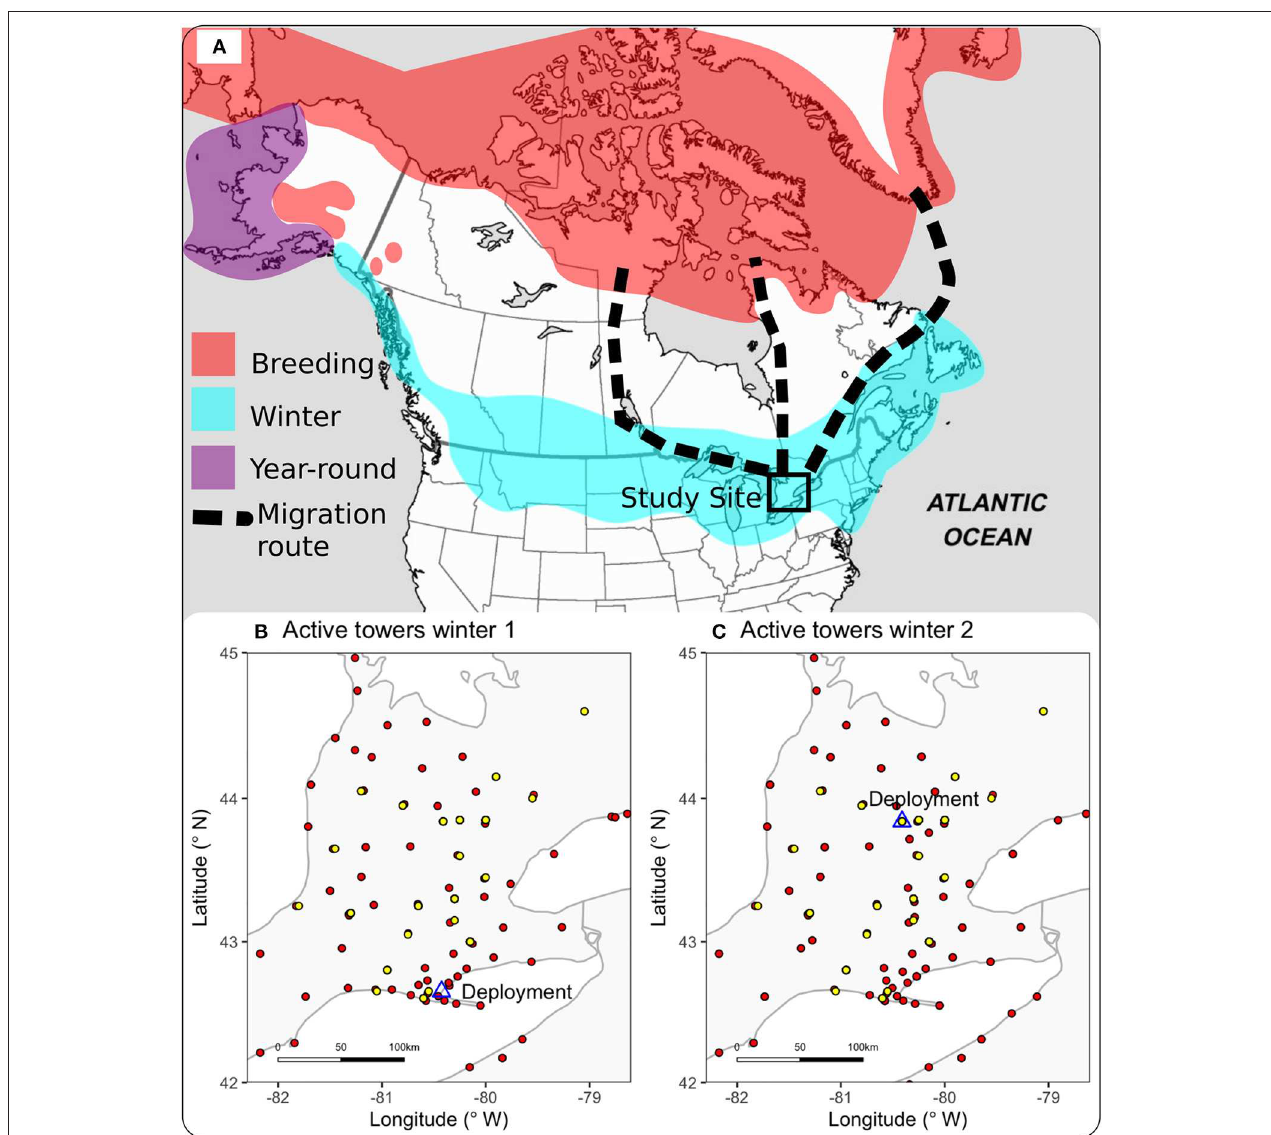
FIGURE 1 | North American range of Snow Bunting and study site. (A) Breeding grounds, wintering sites and year-round resident sites are indicated by color (range based on Montgomerie and Lyon, 2011); most birds in our study population likely breed in Greenland (based on band recoveries; summarized in Macdonald et al., 2012); however, it is possible that some individuals breed in the Canadian Arctic, thus three potential spring flyways are shown. (B,C) Show the ∼ 300 × 300km region of our study, with active Motus receiving stations as red points, tags deployment sites as blue triangles and stations that detected Snow Buntings as yellow